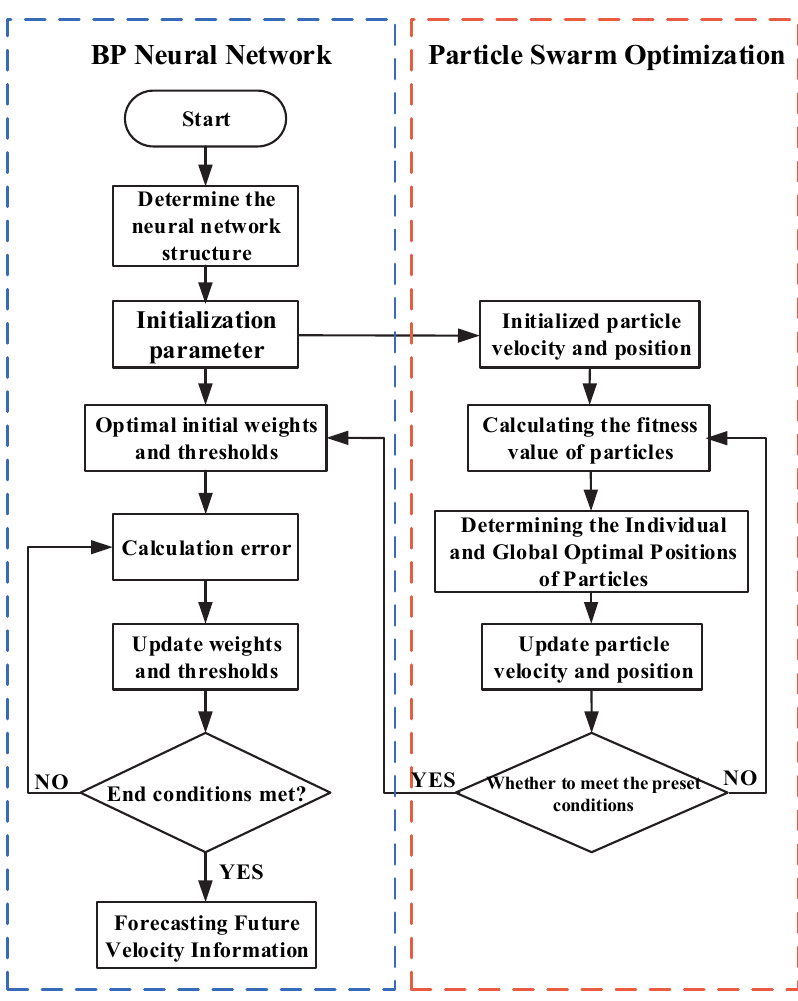
Figure 10. Flowchart of PSO − BP neural network velocity prediction algorithm.